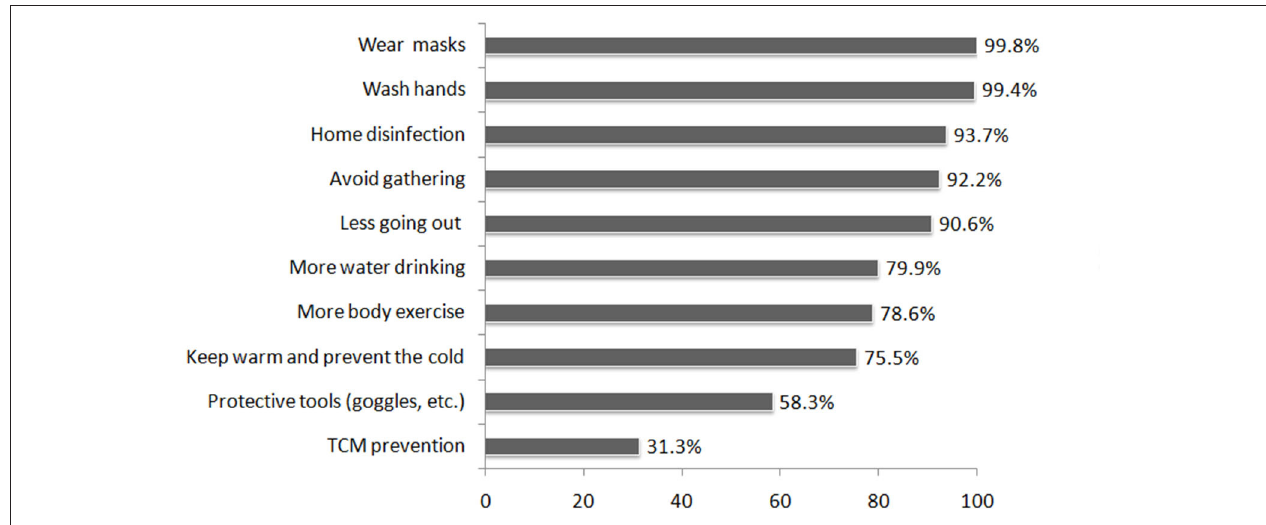
FIGURE 2 | Knowledge rates of COVID-19 prevention measures.